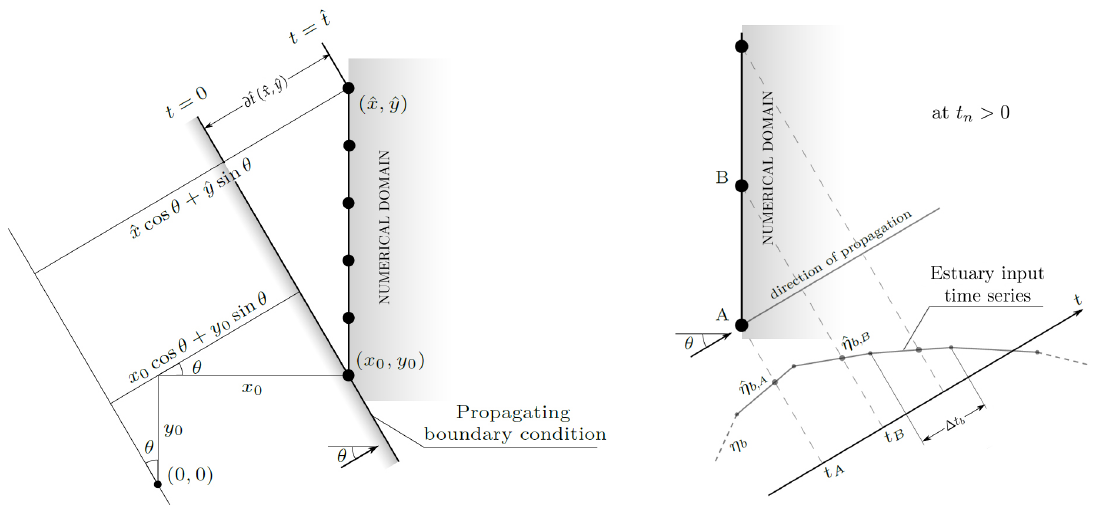
Figure 2. ( Left ) geometric scheme for the case of an estuary boundary condition entering the domain at an angle θ . A single propagating boundary condition is read by the “first contact” node ( x 0 , y 0 ) at time t = 0, and reaches node ( ˆ x , ˆ y ) after a time ∂ ˆ t . ( Right ) scheme for the evaluation of the boundary conditions for water level ˆ η b (and fluid velocity ˆ U b ) for each estuary node, at a generic solution time t n >